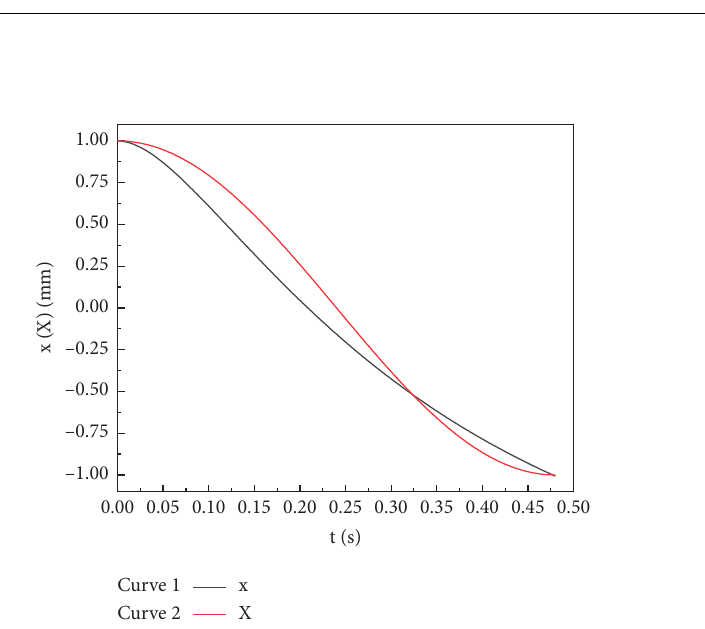
Figure 7: Running track diagram of the carbon brush and the slip ring in one